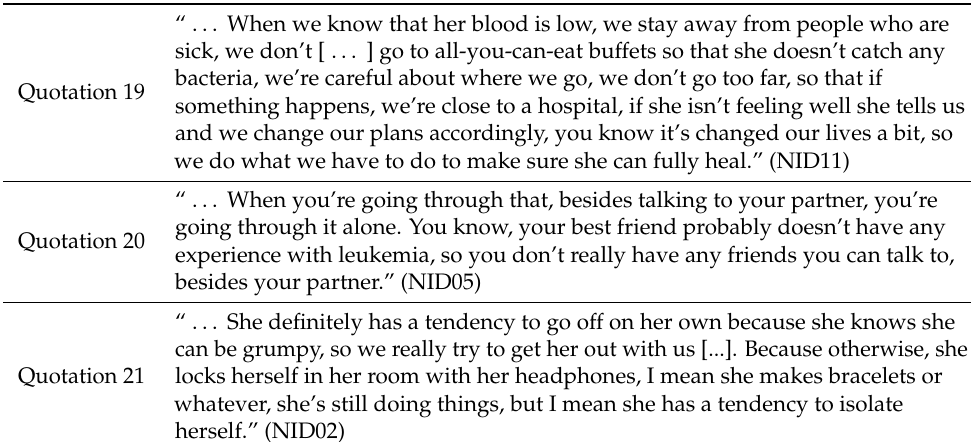
Table 6. Exemplar quotations from interviewed parents for the theme: Adapting relationships outside the